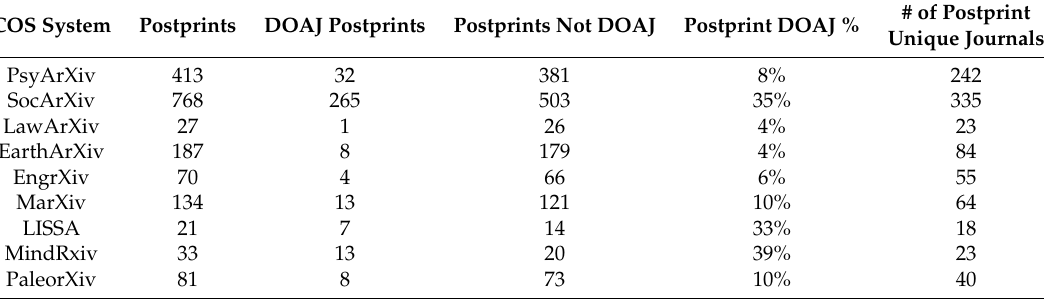
Table 4. Journal and OA status for COS